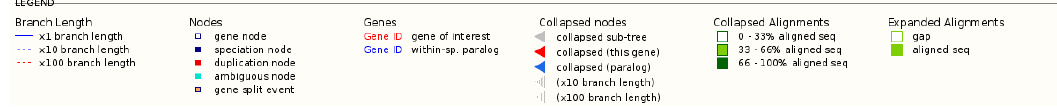
Figure 6. Gene tree for human CYP11A1 , 11B1 , 11C1 , 24A1 , 27A1 , 27B1 , and 27C1 built using Ensembl 84. These CYP11 , 24 , and 27 family genes are paralogs to each other derived from the same ancestral gene via duplication events. The gene tree includes a total of 410 genes from various species. The total number of speciation nodes is 344, and the number of duplication is 52. The number of ambiguous nodes is 13, and there is no gene split event.